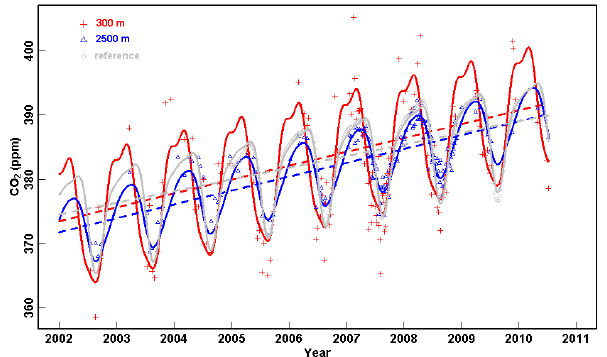
Fig. 11. Time series of CO 2 mixing ratios at 300m, 2500m, and reference marine boundary layer (see text). A linear trend and a third-order harmonic function have been fitted to each group of these data after 2005 (smoothed curves), and the dashed lines show the linear trend from the